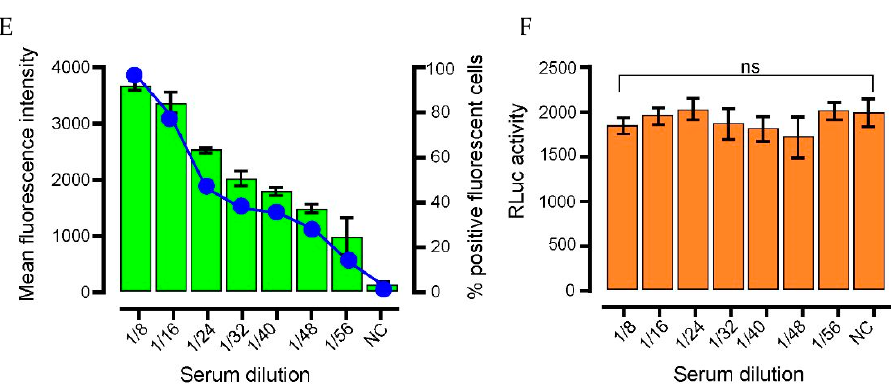
Figure 2. Immunofluorescence characterization of anti-SARS-CoV-2 IgG. ( A ) Indirect staining of A549 cells incubated with serum from a SARS-CoV-2 positive patient and FITC-conjugated antibodies against human IgG. ( B ) Confocal Airyscan images for ( A ) at a dilution of 1:40. ( C ) Negative controls; (i) serum from a PCR confirmed negative donor sample, (ii) spike-expressing cells without serum; (iii) cell-only controls. ( D ) Serum from a pre-SARS-CoV-2 pandemic donor. Nuclei were stained with DAPI (blue). Scale bar: 100 µm and 10 µm. ( E ) Dose–response detection from PCR-confirmed positive donor serum. A two-fold dilution series from 1:8 – 1:56 was assessed. Bars (green): mean fluorescence intensity; connected circles (blue): % of positive fluorescent cells. Data are from 10 cells per-dilution and were quantified using Fuji. Data are means ± SEM ( F ) pRL-TK Renilla luc (RLuc) was included as an internal transfection control. Bar heights represent the mean of two biological replicates; error bars: SEM.